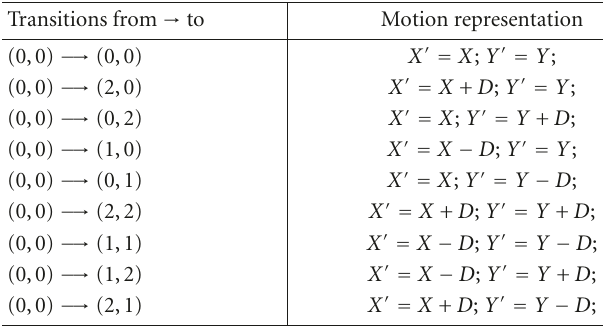
Table 1: Possible motion representation of state (0,0) given by state-transitions of the SIMM model.